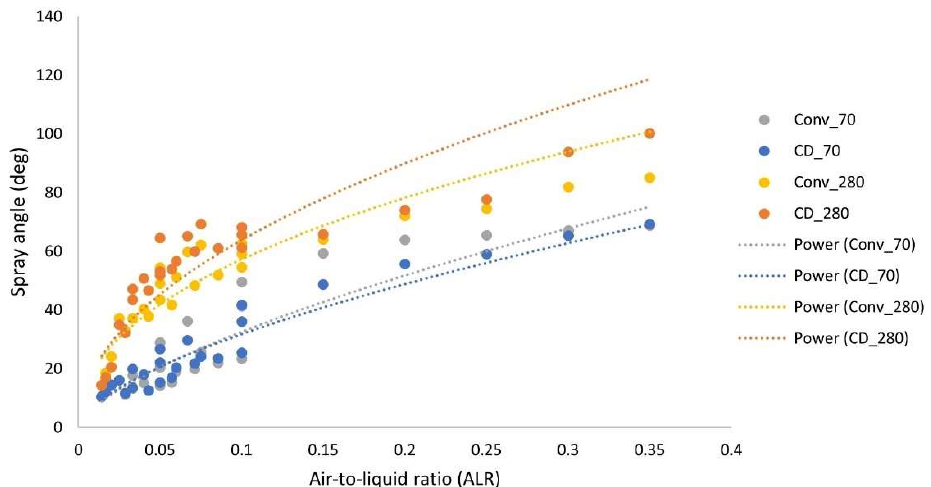
Figure 11. Spray angle measurement variation with ALR for the converging and converging–diverging (CD) atomizer cases with 70 and 280 µm sheet thickness.